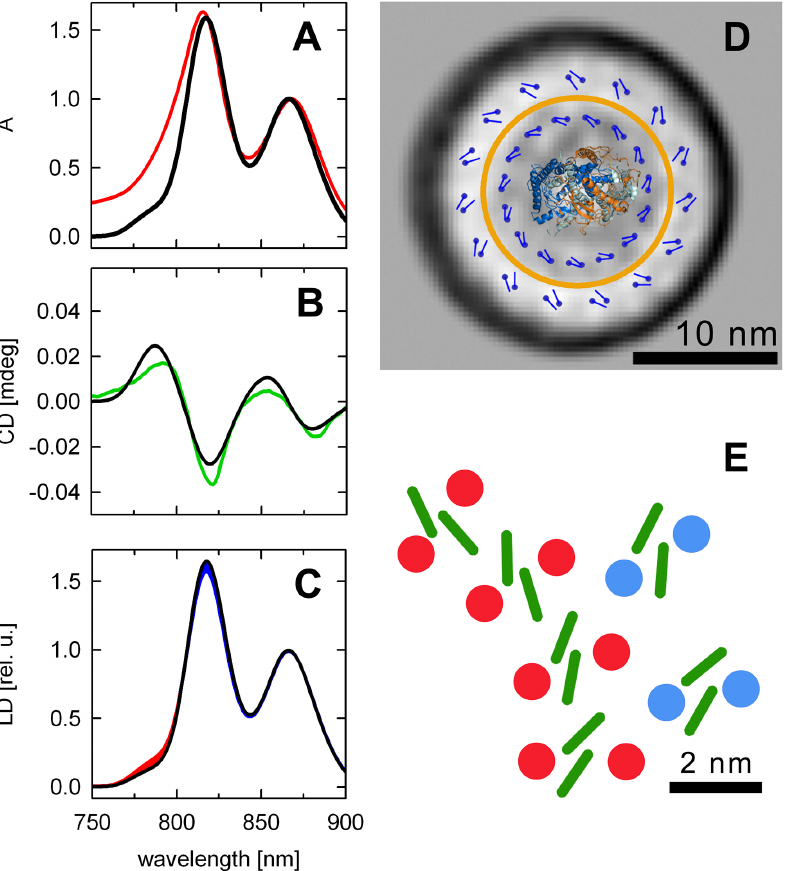
Fig 4. Model of G . phototrophica light-harvesting complex. Panels on the left show (A) absorption,(B) CD, and (C) LD spectra. The recordedNIR spectra (in color) are compared with the simulatedsteady-state spectra (in black). Blue area in (C) depicts the spectral regionhavingLD > absorbance, red area marks the regionwith LD < absorbance (after normalization to B868 maximum). (D) Arrangement of BChl moleculesin the complexused to calculatethe steady-state spectra in (A-C). Yellow ring indicatesthe size of the LH1 complex from R . rubrum for comparison. (E) Detail of the section of the complex showingthe hypothetical positionof protein helices(red and blue dots) and BChl a moleculesin green. These are taken directly from the structure of light-harvesting complexes. BChl, bacteriochlorophyll; CD, circular dichroism;LD, linear dichroism;LH1, light-harvesting complex 1; mdeg, millidegree;NIR, near infrared region; rel. u., relative units.